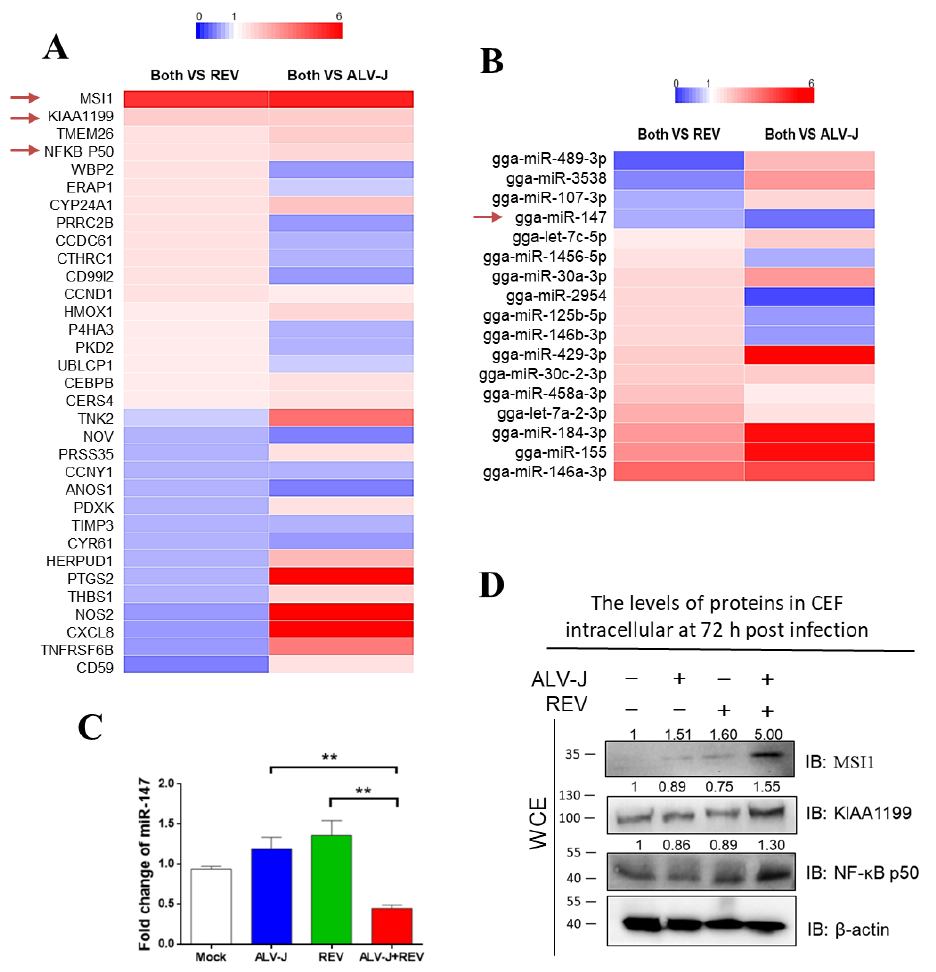
Figure 2. Identification of host molecules responsible for synergistic oncogenicity induced by ALV-J and REV. ( A ) Thirty-three differentially expressed proteins were common between cells co-infected with both viruses and infected with either ALV-J or REV. ( B ) miRNA whole-genome sequencing of infected CEF cells at 72 hpi. Seventeen differentially expressed miRNAs were common between co-infected and mono-infected cells. ( C ) ALV-J and REV infections synergistically inhibited the miR-147 expression level in CEF cells at 72 hpi, as detected using qPCR. ( D ) ALV-J and REV infections synergistically elevated MSI1, KIAA1199, and NF- κ B p50 protein levels in DF-1 cells at 72 hpi, as detected using WB. **p ≤ 0.01 determined using Student′s t -test versus the Neg. Ctrl. group.